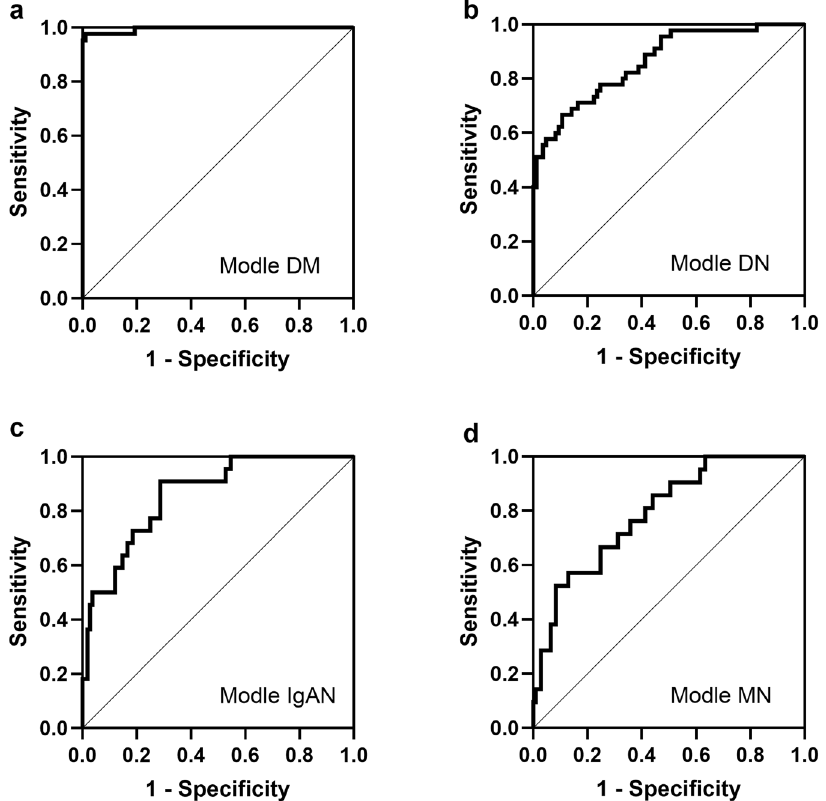
Fig. 2 The diagnostic accuracy of the diagnostic models was determined by ROC analysis in the con fi rmation cohort. a – d The ROC analysis is shown for Model DM, Model DN, Model IgAN, and Model MN in the con fi rmation cohort. DM diabetes mellitus, DN diabetic nephropathy, IgAN IgA nephropathy, MN membranous